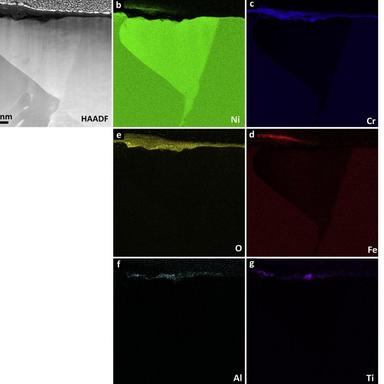
Evolution of the average PIO as function of the oxidizing condition R (eq.. The data from Molander et al. is also plotted as square root of the initiation time (solid green line and green diamonds) so that the dependence of the time-to-initiation and the PIO as a function of the oxidizing condition can be compared. (For interpretation of the references to colour in this figure legend, the reader is referred to the Web version of this article.)